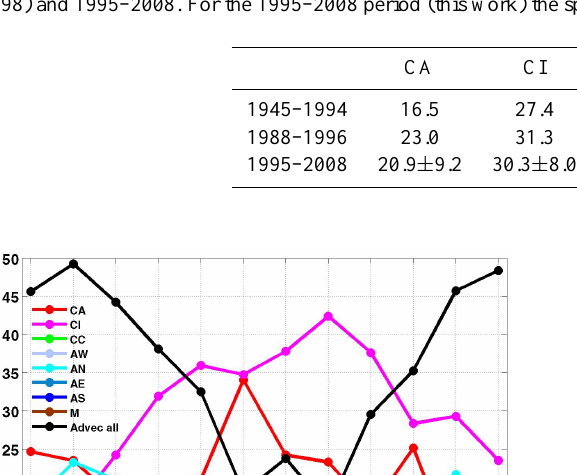
Table 2. Yearly frequency distribution in percent of SYNALP weather types for 1945–1994 (Wanner et al., 1998), 1988–1996 (Lugauer et al., 1998) and 1995–2008. For the 1995–2008 period (this work) the spread in data corresponding to two standard deviations is given.